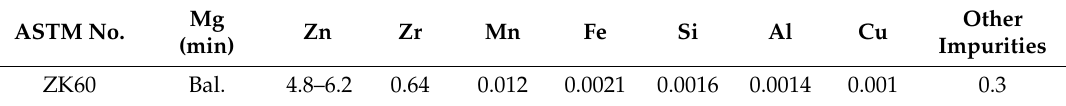
Table 1. Chemical composition of ZK60 .